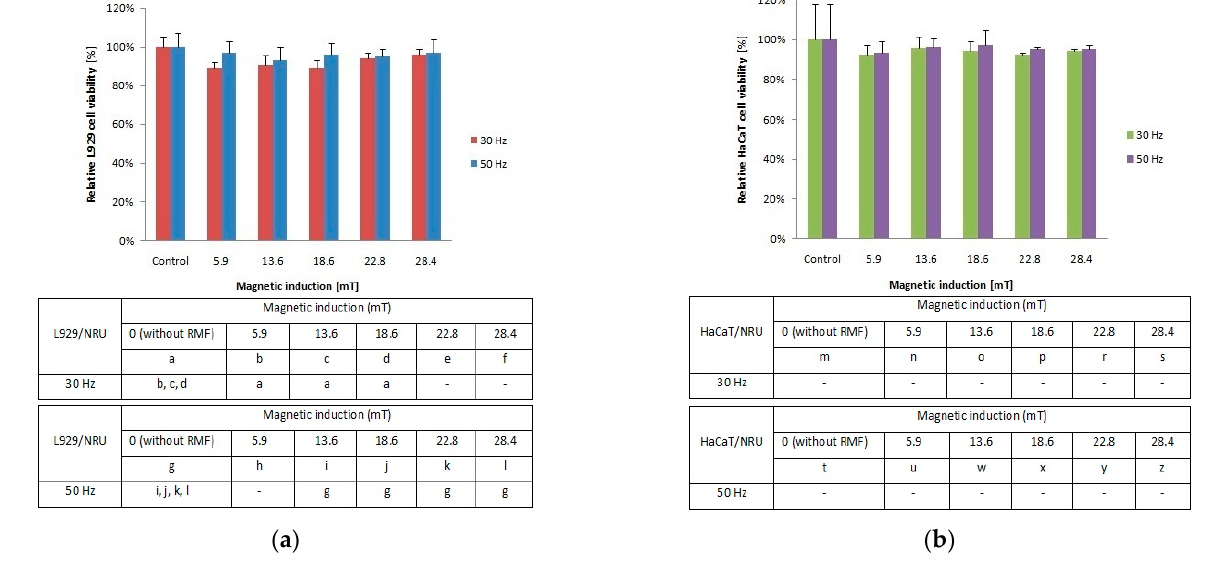
Figure 2. Relative viability after 4-hour exposition to different magnetic induction and frequency of RMF. ( a ) NRU assay results for L929 cell line; ( b ) NRU assay results for HaCaT cell line lines (all samples were compared to control; p -values < 0.05 were considered significant and were represented by small letters).